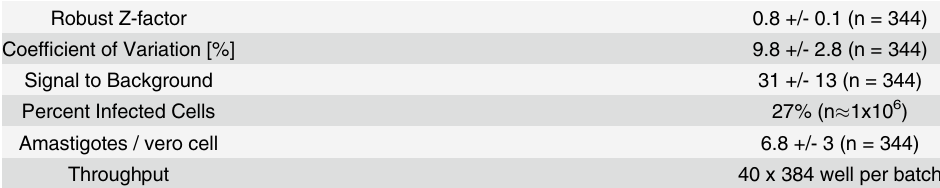
Throughput 40 x 384 well per batch Values are averages +/- standard deviation, n is number of plates for Z-factor, %Coef fi cient of Variation, Signal:Background (S:B) and Amastigotes / vero cell (calculated from 32 control wells on each plate, includes both infected and non-infected cells) and number of Vero cells for Percent Infected Cells. Coef fi cient of Variance is for infected vehicle control wells. For S:B, signal is average number of amastigotes / Vero cell in vehicle control wells, background is average number of amastigotes / Vero cell in 100% effect (50 μ M Nifurtimox) control. Percent Infected cells and Amastigotes / Vero cell were determined at